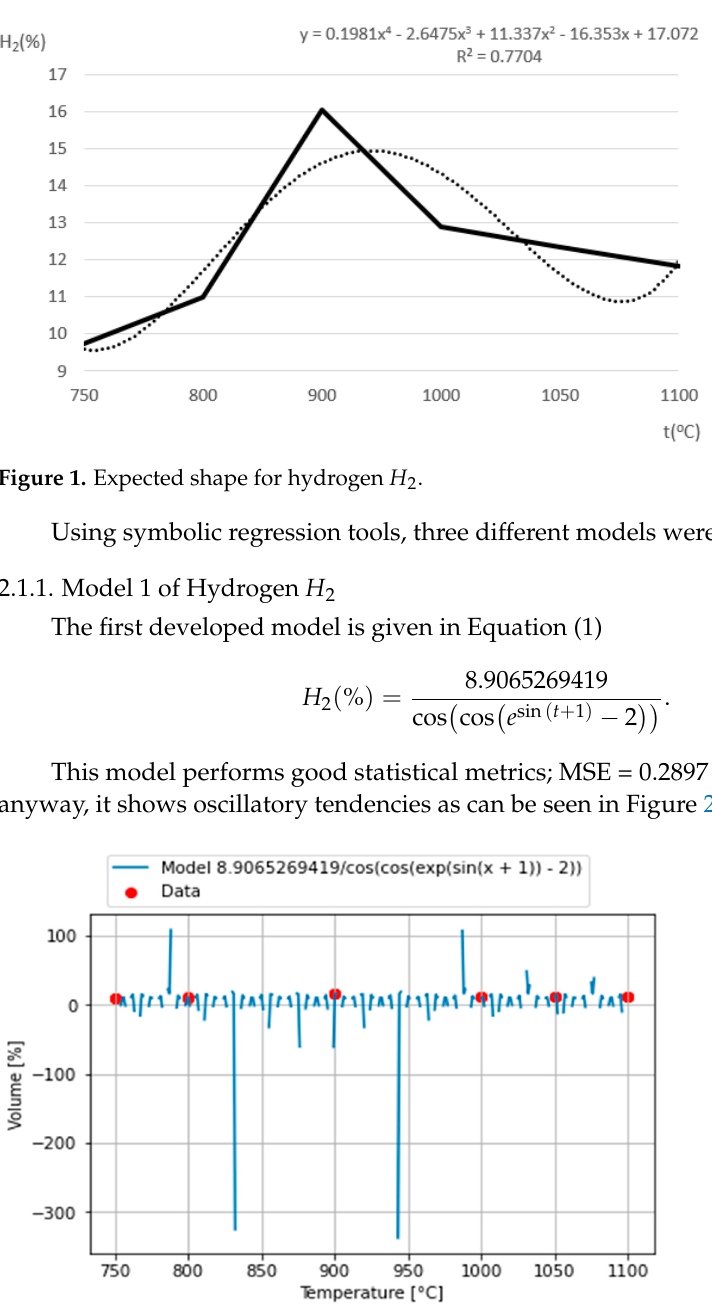
Figure 2. Model 1 of hydrogen H 2 .